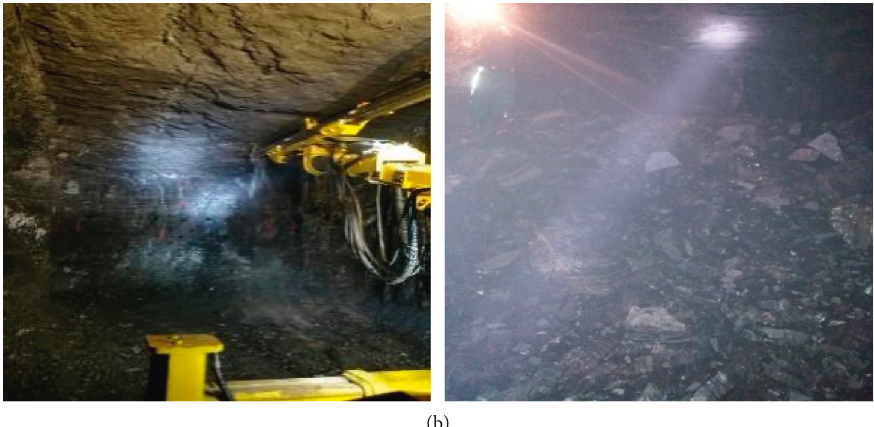
Figure 7: Comparison of on-site blasting effects. (a) Original plan blasting effect. (b) Four-hole blasting